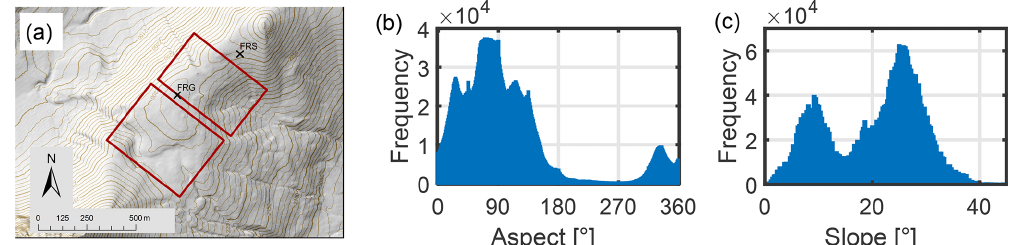
Figure 2. Topography of the study site: (a) an overview of the two areas of investigation (red rectangles) with the location of the two weather stations (black crosses) on the alpine Fortress Ridge, Alberta, Canada; (b) the aspect and (c) slope distribution of the snow-covered area on 27 May 2015 (at a spatial resolution of 10cm, N > 3 × 10 6